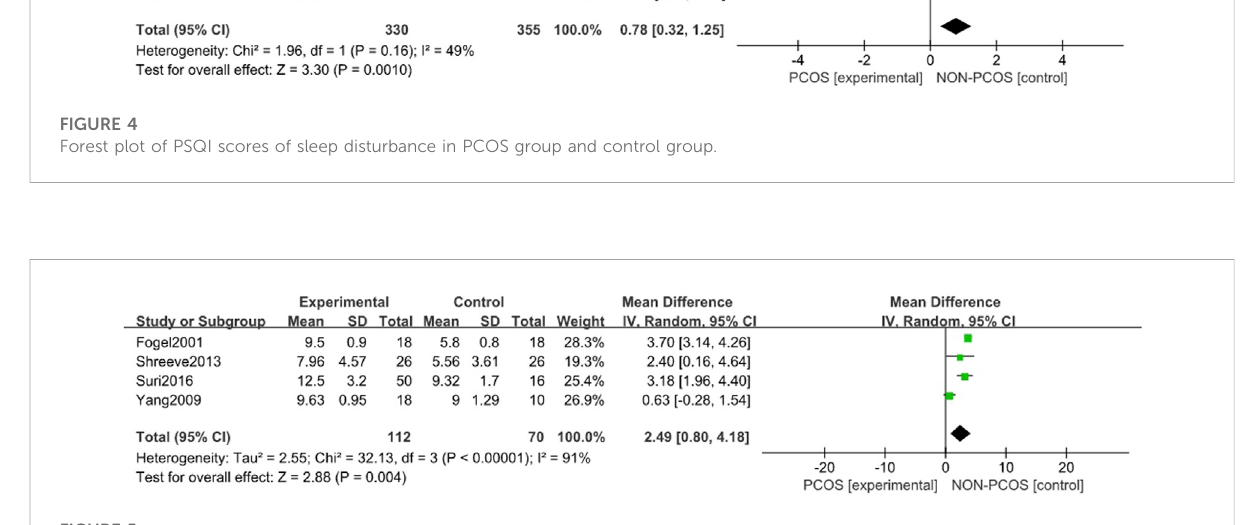
Forest plot of ESS scoress in PCOS and control groups (before heterogeneity was